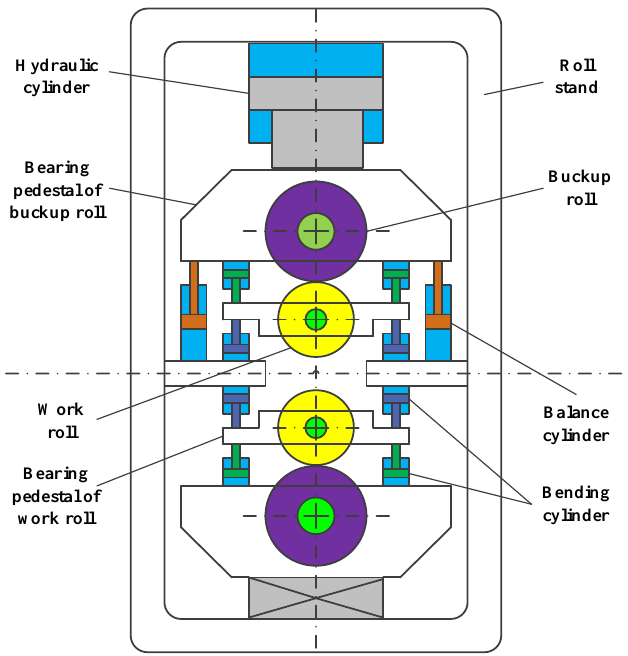
Figure 1. Structural schematic diagram of load.